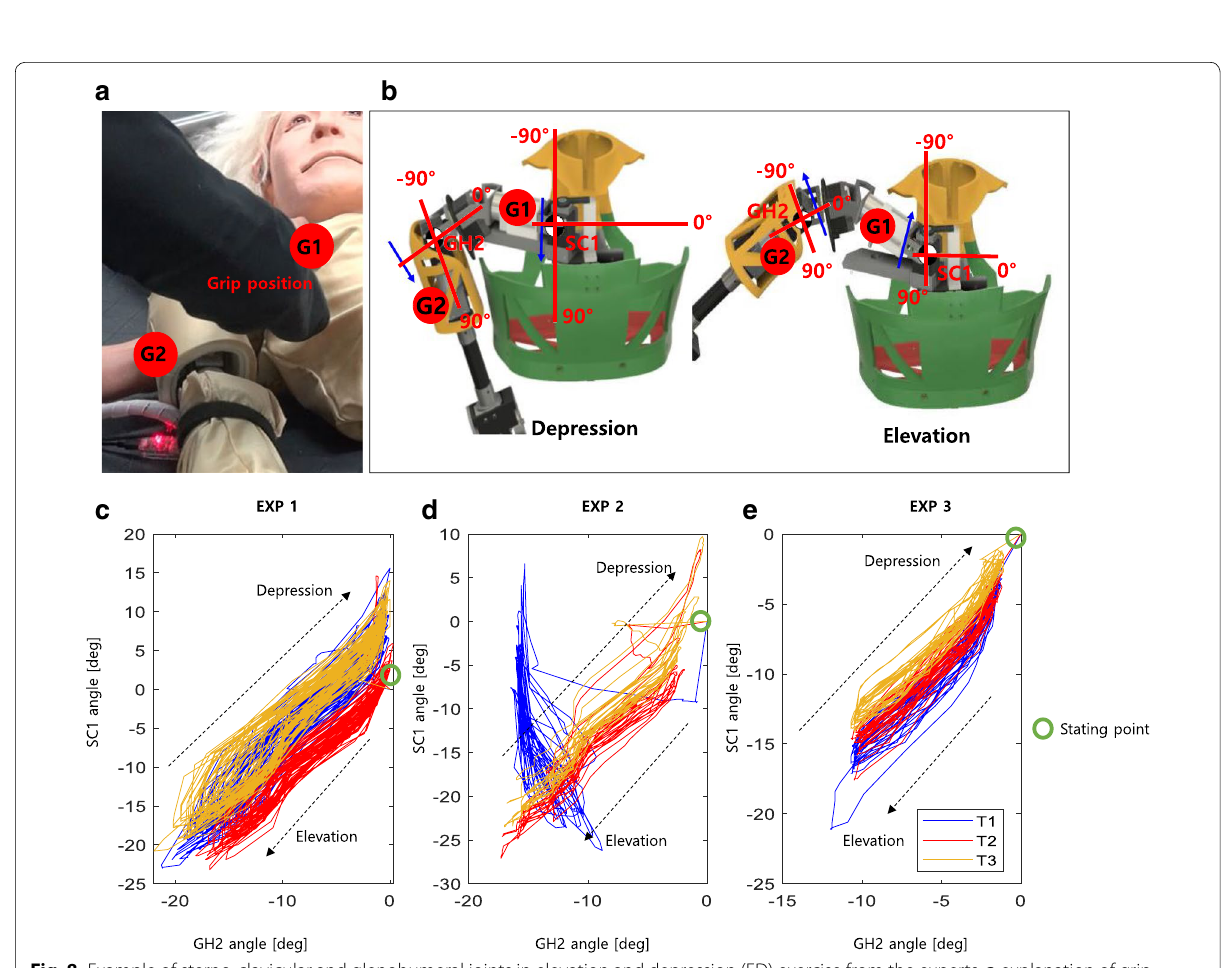
Fig. 8 Example of sterno‑clavicular and glenohumeral joints in elevation and depression (ED) exercise from the experts: a explanation of grip positions; b mechanism of elevation and depression; c angle curves between SC1 and GH2 joints. EXP expert, SC sterno‑clavicular joint, GH glenohumeral joint, Tn the number of tests. The green circle indicates the starting point of the